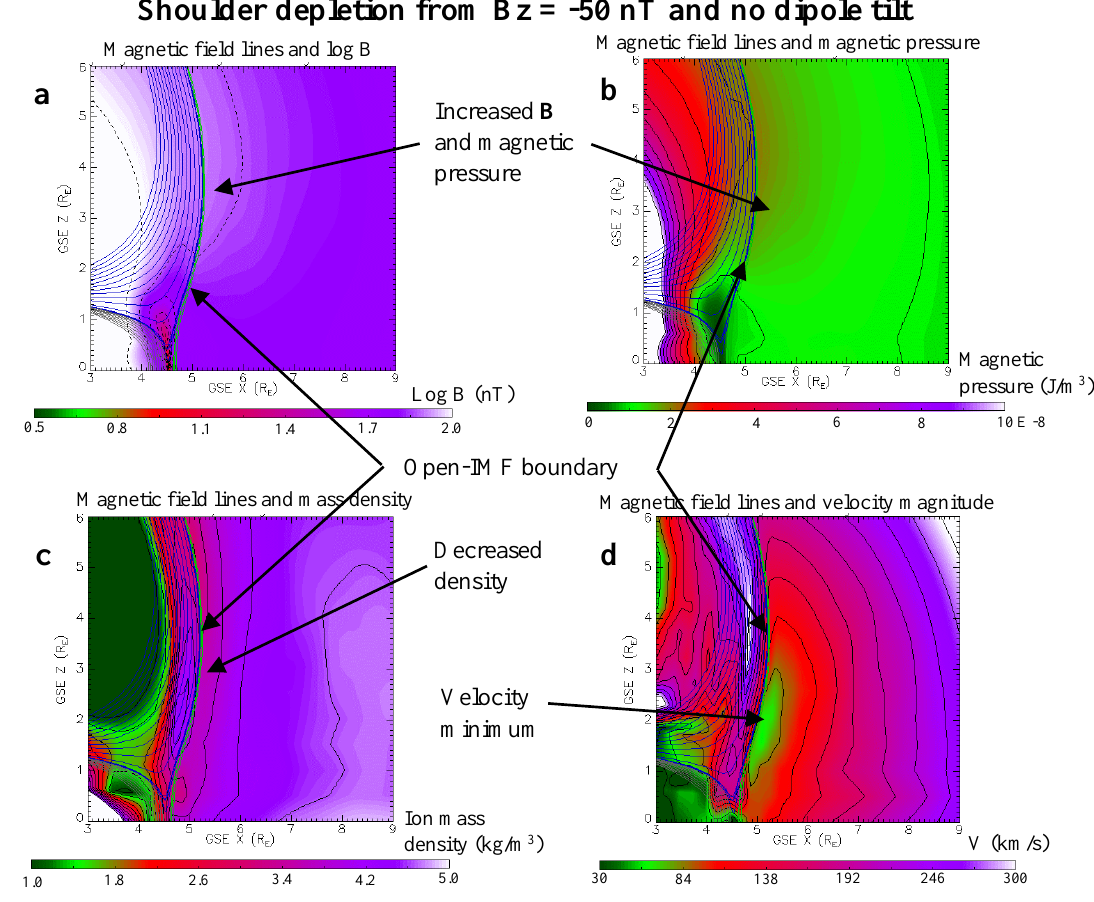
Fig. 8. Shoulders develop above both cusps in simulations with no dipole tilt, but with exceptionally strong driving IMF (50nT). The panels display a region of the XZ plane at Y = 0. Magnetic field lines displayed are open and attached to the Northern Hemisphere ionosphere. The backgrounds in (a) and (b) are the log of B and magnetic pressure, respectively. (c) The plane is colored with the mass density. (d) Velocity magnitude provides the background. The depletion layer signatures are highlighted by the arrows, and their location relative to the open-IMF boundary is provided by the traced magnetic field